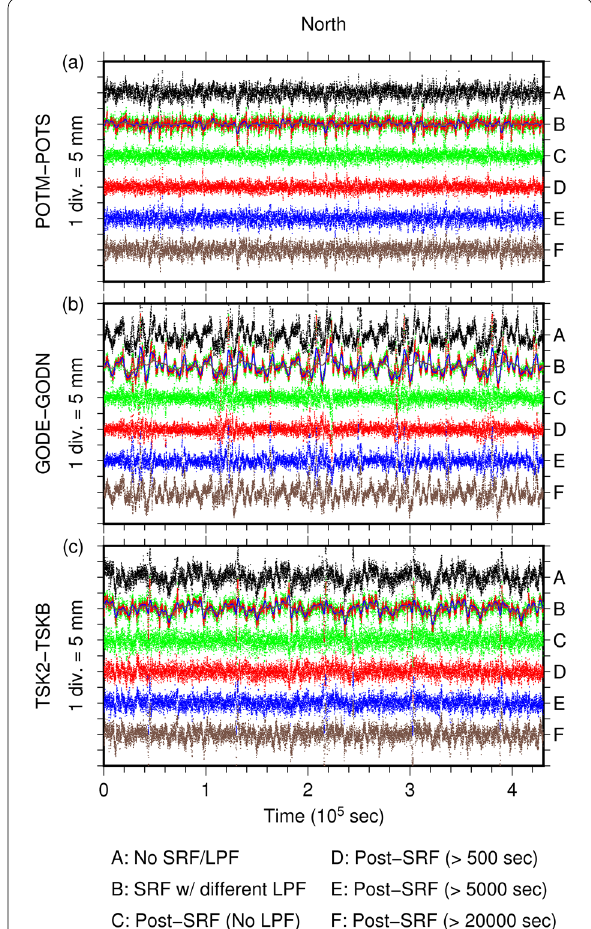
Fig. 6 An example of the north component of coordinates before and after sidereal filtering (SRF). a Coordinates of baseline POTM-POTS before (A) and after sidereal filtering by a sidereal filter without (C) and with low-pass filtering using a cut-off period of 500 (D), 5000 (E), and 20,000 (F) seconds. Sidereal filters used are drawn with the corresponding color for each low-pass filter setting at row (B). b Same as a but for GODE-GODN. c Same as a but for TSK2-TSKB. The same plots but for east and up components are provided in